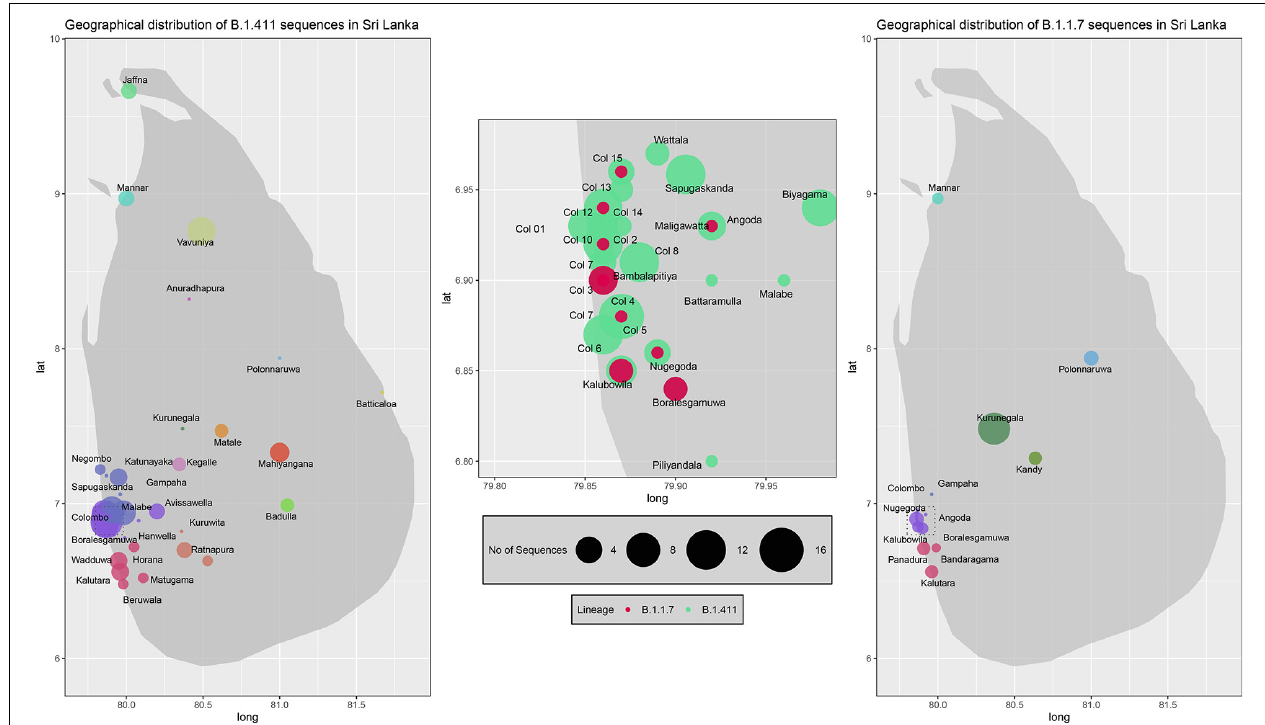
FIGURE 5 | Geographical distribution of SARS-CoV-2 B.1.411 and B.1.17 lineage infections in Sri Lanka sampled from October 2020 to April 2021. Radius of each bubble accounts for the number of sequences reported from its representing district and the colour code based on the location is adopted from the Figure 4 . Colombo district is expanded in the middle to visualize its